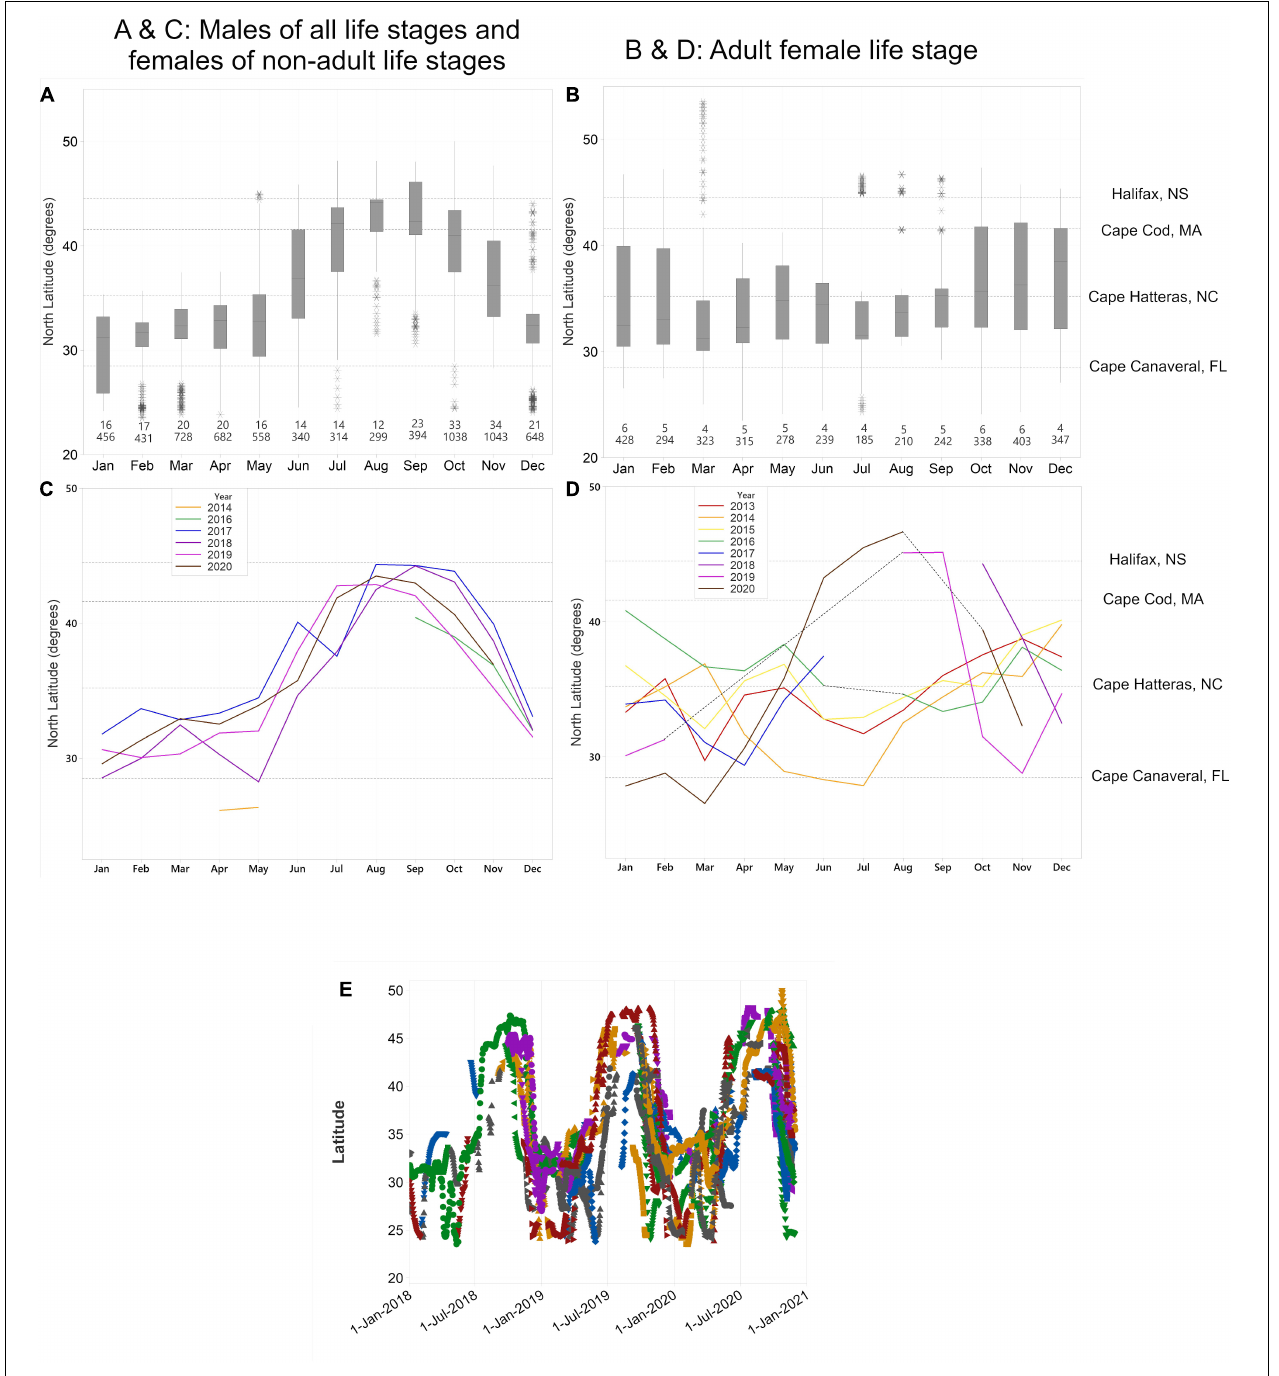
FIGURE 5 | Box-and-whisker plots (A,B) , summarized for all years, all sharks; and means of monthly latitude (C,D) within each year of all regularized tracks from white sharks tracked between 2013 and 2020 ( A,C = males of all life stages and females of all non-adult life stages; B,D = adult females). Latitudes of regularized daily locations for individual sharks (E) tracked over a 2-year period (November 2018 – November 2020) to show individual variability in movements. In panels (A,B) boxes represent interquartile range, whiskers are 1.5 × IQR, asterisks are outliers, and numbers above each month represent # of individuals (top number) and total number of locations (bottom number) in each respective month. Lines in panels (C,D) represent mean latitude during each month and broken lines in panel (D) connect gaps within years with no data during those months. Colors and symbols in panel (E) denote individual sharks with locations during that period. Dotted horizontal lines in each figure represent latitudes from north to south of Halifax, Nova Scotia; Cape Cod, Massachusetts; Cape Hatteras, NC, and Cape Canaveral, FL as labeled to the right of figures.